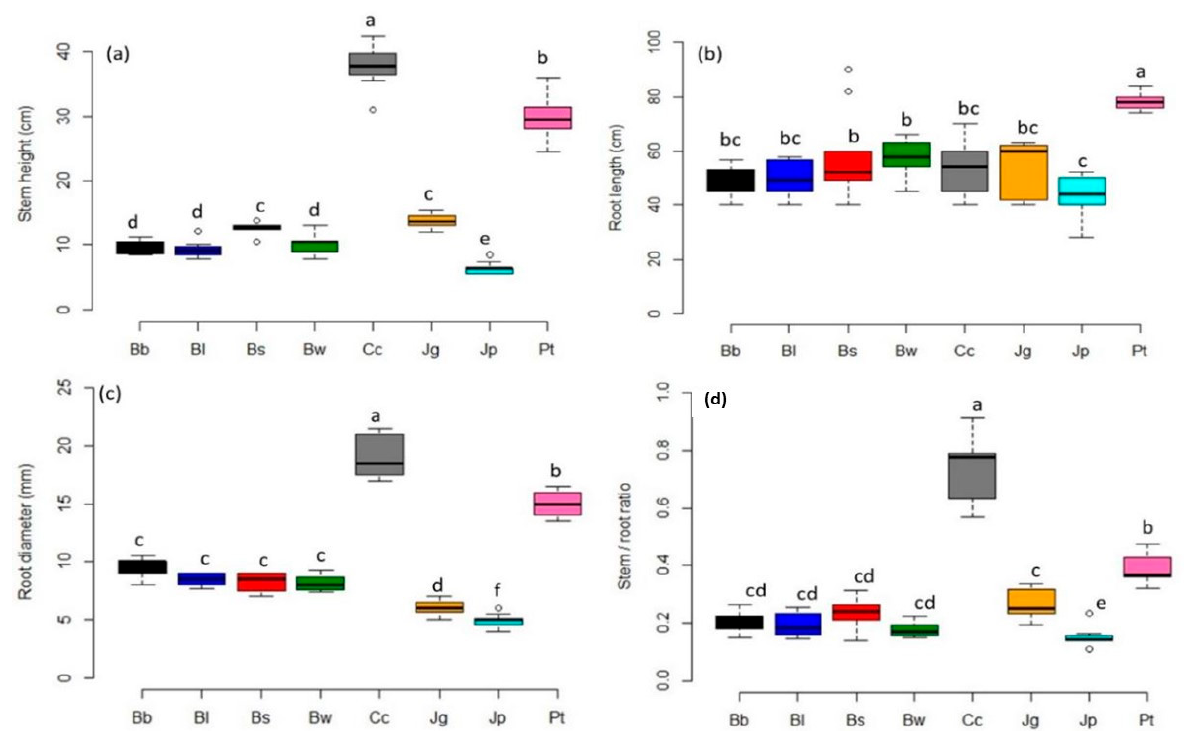
Figure A3. Seedling growth of the woodland tree species, 2 years after planting. ( a ) Height, ( b ) root length, ( c ) root diameter at 15 cm of collar level (RD) and ( d ) stem height/root length ratio. Cc: C. collinum and Pt: P. tinctorius (ES); Bb: B. boehmii , Bl: B. longifolia , Bs: B. spiciformis , Bw: B. wangermeana , Jg: J. globiflora and Jp: J. paniculata (LS). N = 3 replicates and 3 seedlings per replicate and per species. Letters indicate differences in species, according to the Tukey HSD test ( p < 0.05). Table A3. Analysis of variance of the effect of age and species on the ratio of stem height-to-stem diameter at collar level (RHD: standard error = 0.016, N = 48) and the seedling volume index (SVI, standard error = 0.056, N = 48).